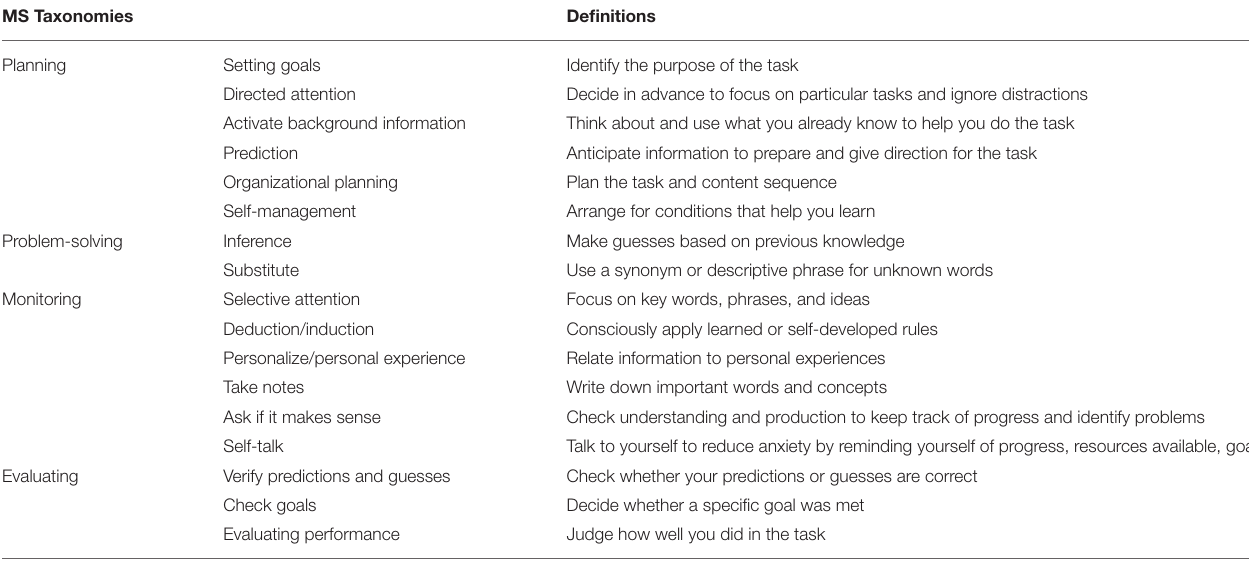
TABLE 1 | Definitions and taxonomies of strategic competence in this study. MS